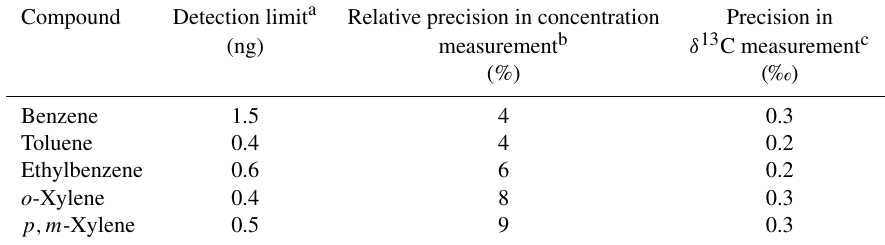
Table 1. Performance of the system for analysis of volatile organic compounds in ambient air. Compound Detection limit a Relative precision in concentration Precision in (ng) measurement